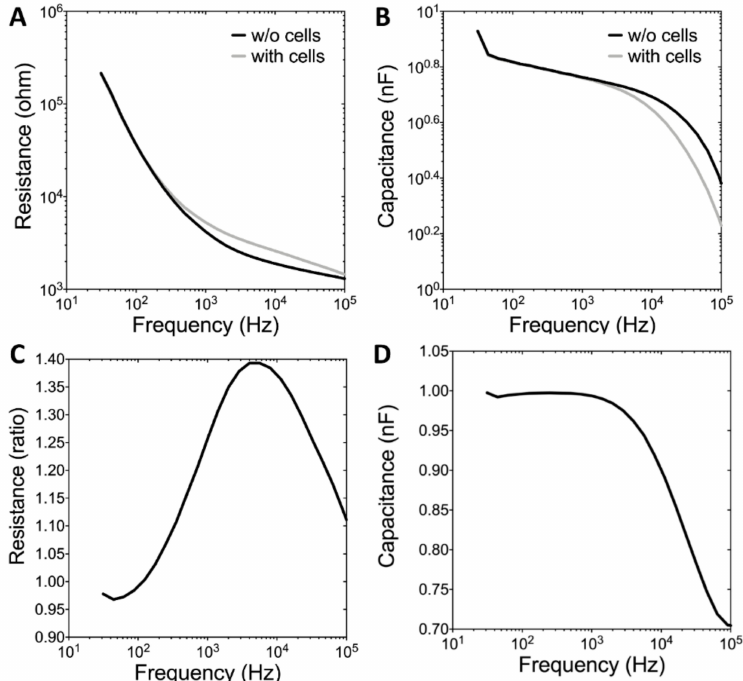
Figure 4. ( A ) Resistance data and ( B ) capacitance data as a function of frequency obtained from cell-free (dotted line) and cell-covered (solid line) electrodes. ( C ) Normalized resistance and ( D ) normalized capacitance obtained from electrodes confluent with U-87 MG cells by dividing with the corresponding quantities for the cell-free